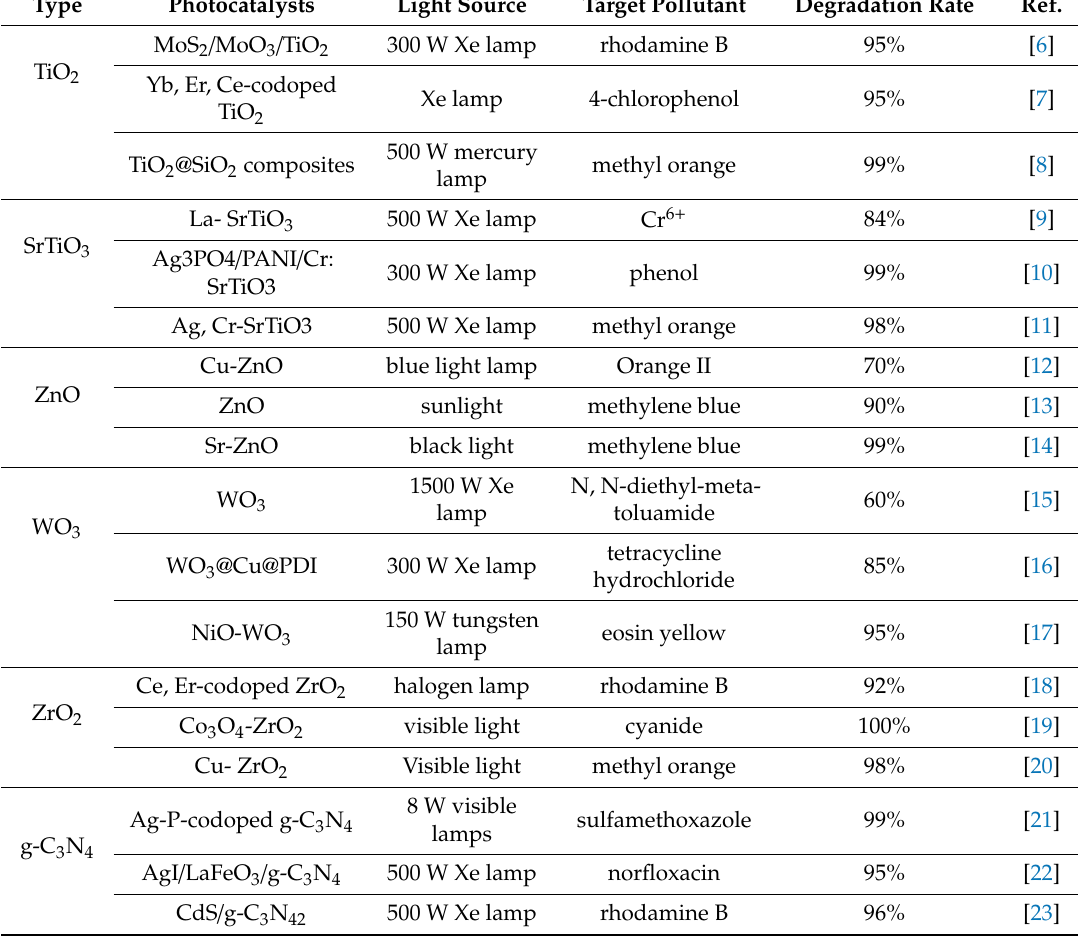
Table 1. The published data of di ff erent photocatalysts and their performance.